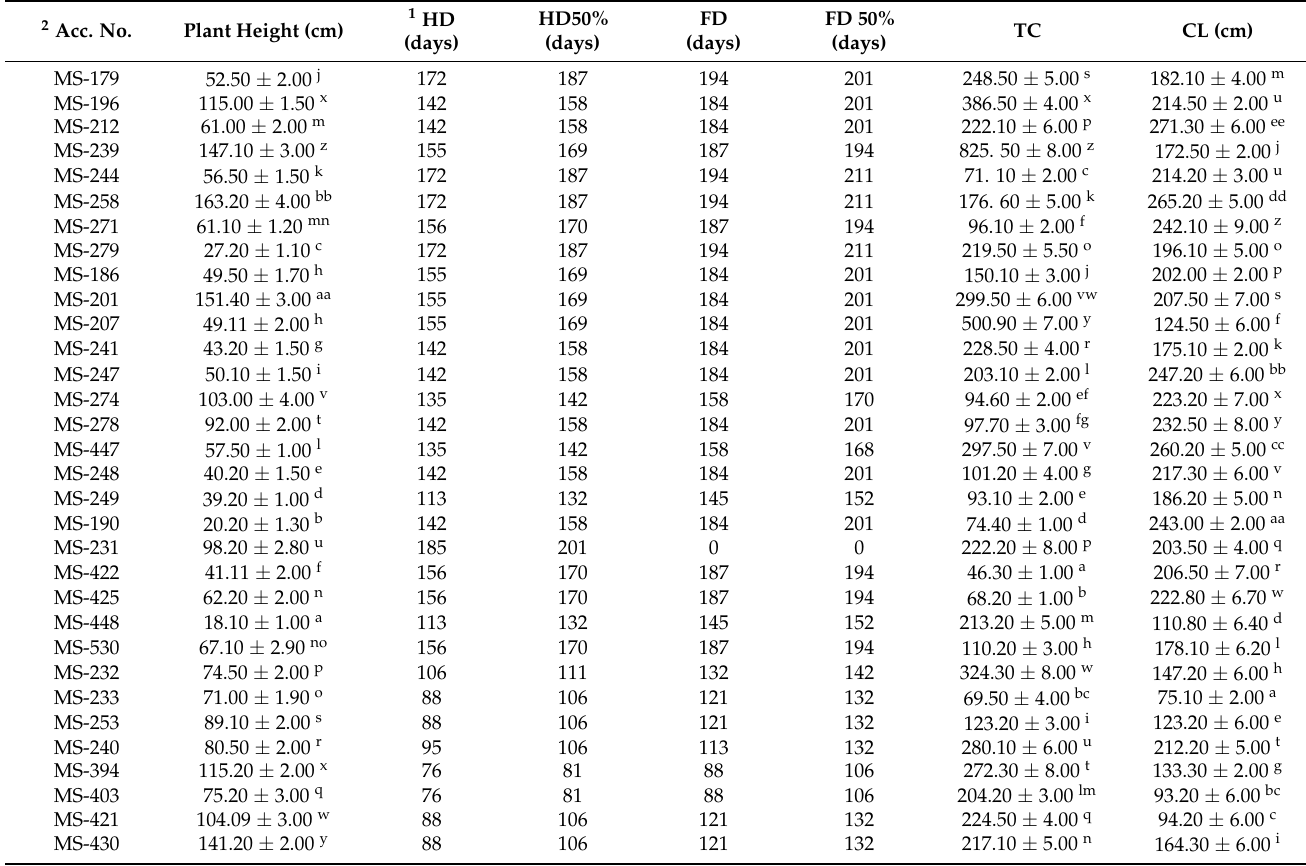
Table 2. Morphological characteristics of the selected M. sacchariflorus